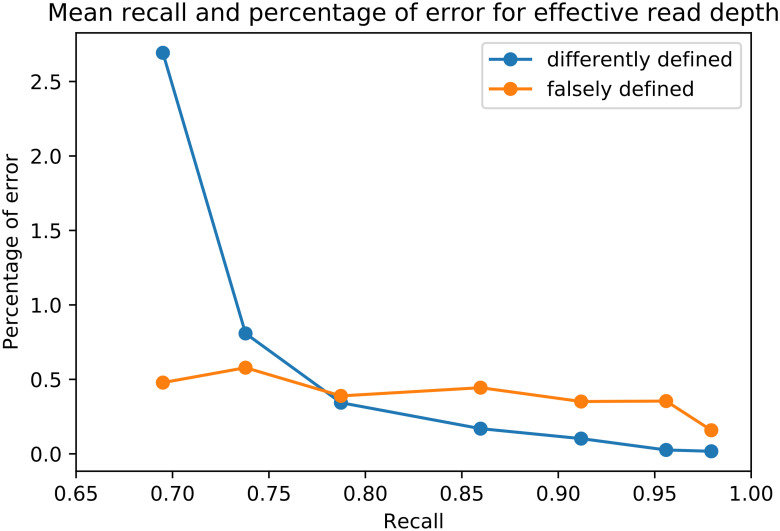
Mean recall and percentage of false positive errors for effective read depth.With increasing effective read depth of 30, 100, 300, 1000, 3000, 10000, and 30000, the recall increases and the false positive errors of defining a relationship that is defined differently or undefined in the MAR decreases.